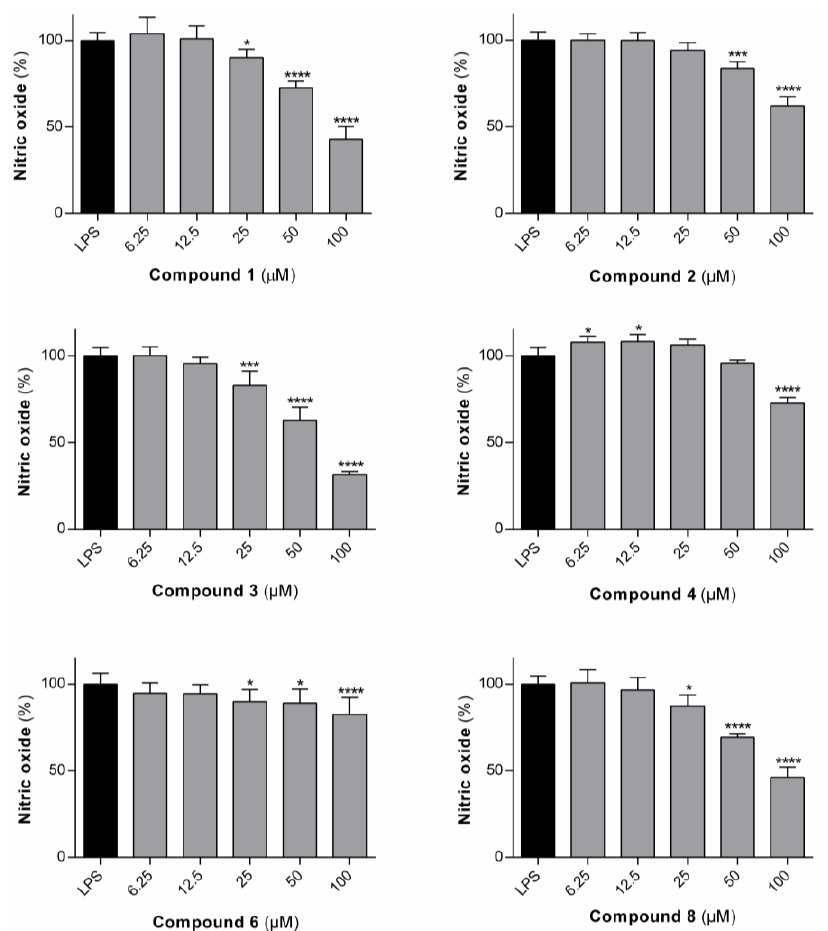
Figure 4. LPS-induced • NO production in rat macrophages in the presence of the compounds 1 – 4 , 6 and 8 for 24 h. Values are shown with mean ± SD. * p ≤ 0.05; *** p ≤ 0.001; **** p ≤ 0.0001. The results for compound 1 and 2 , reported previously, are included for comparison